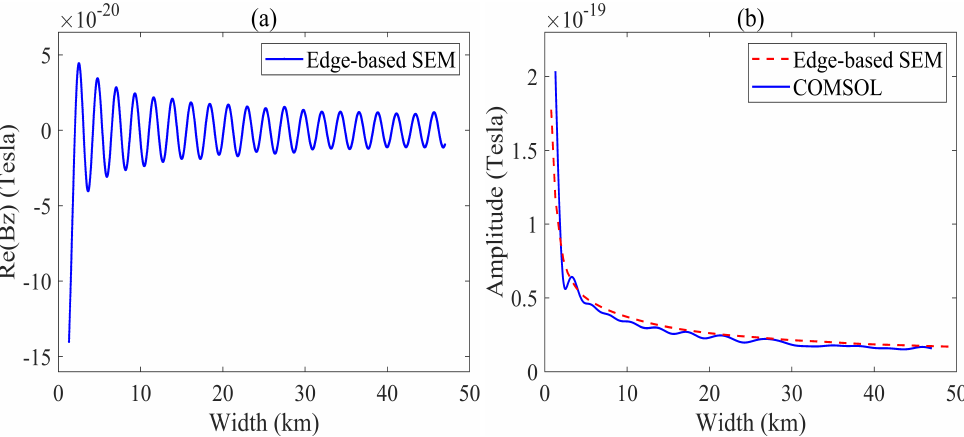
Figure 5. Induced magnetic fields on receivers at 500 m above the sea level. ( a ) vertical component of the magnetic field calculated by edge-based SEM. ( b ) amplitudes of the magnetic field calculated by edge-based SEM and